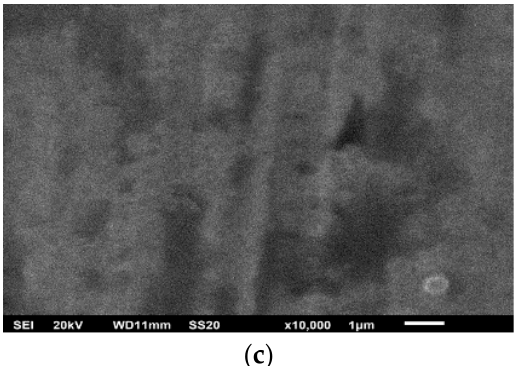
Figure 2. SEM images of the Fe-Cr-Al foil surface at different magnifications after heating at 650 °C for 1 h: ( a ) 1000 times, ( b ) 3000 times, ( c ) 10,000 times.